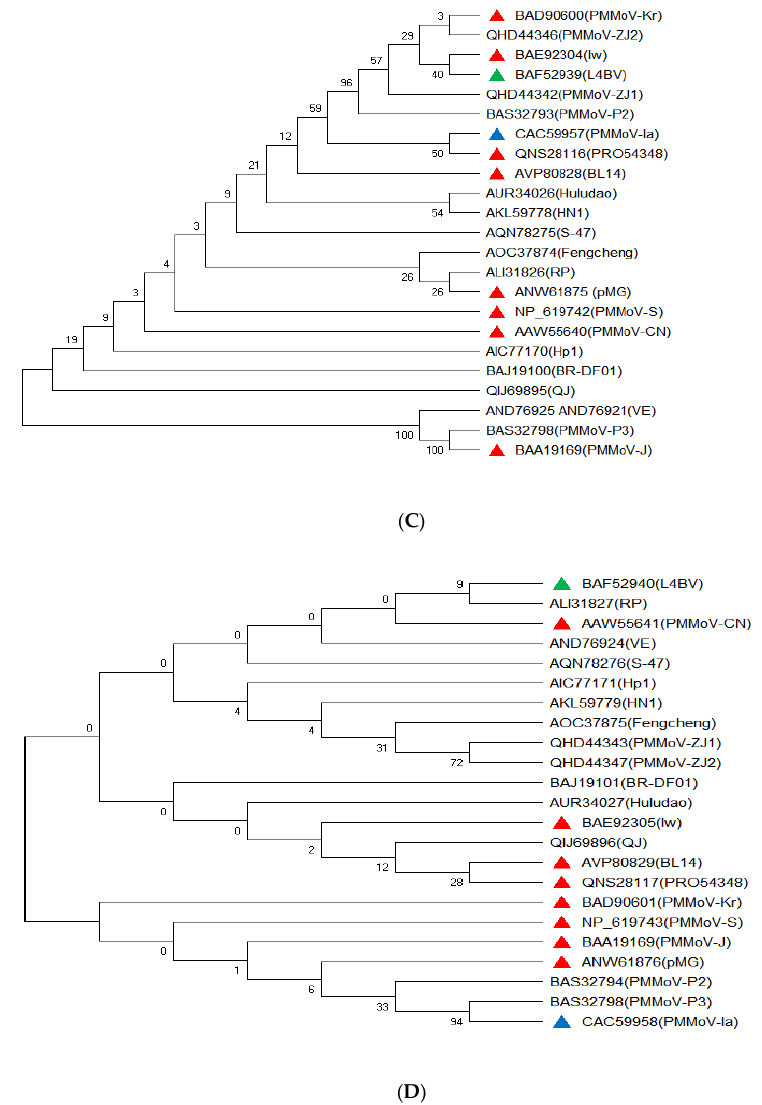
Figure 2. Phylogenetic tree showing the relationships among isolates of PMMoV based on sequences of RNA-dependent RNA polymerase (RdRp) (( A ), 183 kDa), read-through protein (( B ), 126 kDa), movement protein (( C ), 30 kDa), and coat proteins (( D ), 17 kDa). The protein sequences were downloaded from the NCBI genome database (https://www.nvbi.nlm.nih.gov/) and used forphylogenetic tree conduction using the MEGAXsoftware. The red, blue, and green triangles in- dicate examples of P1.2; P1.2.3, and P1.2.3.4 pathotypes, respectively.